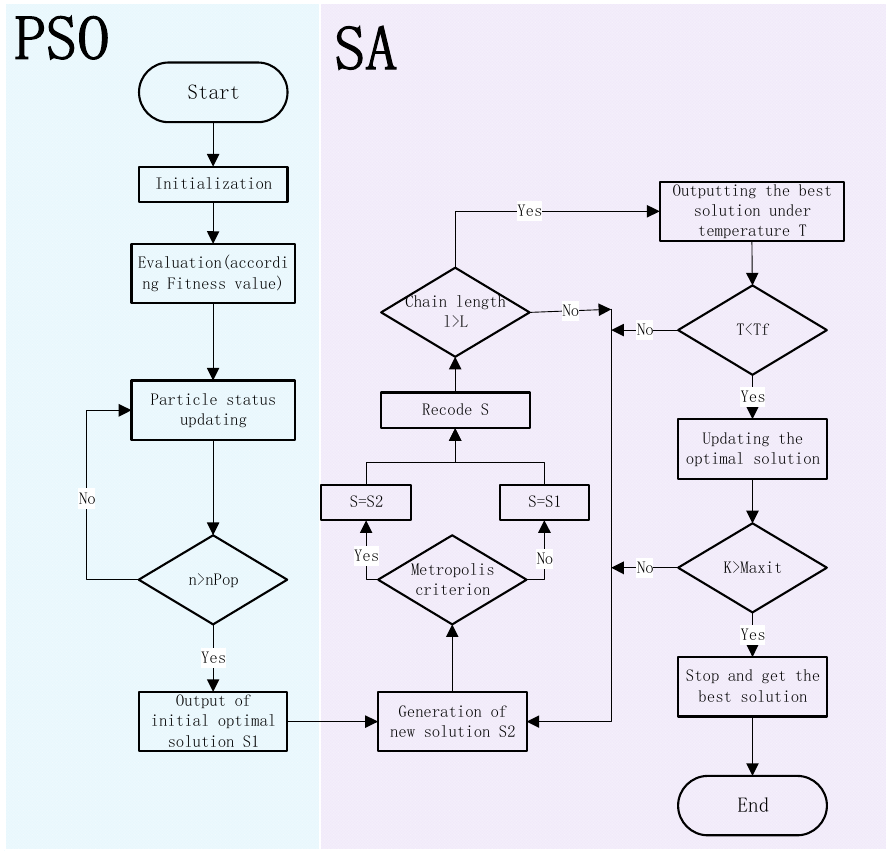
Figure 1. The Flowchart of PSOSA.